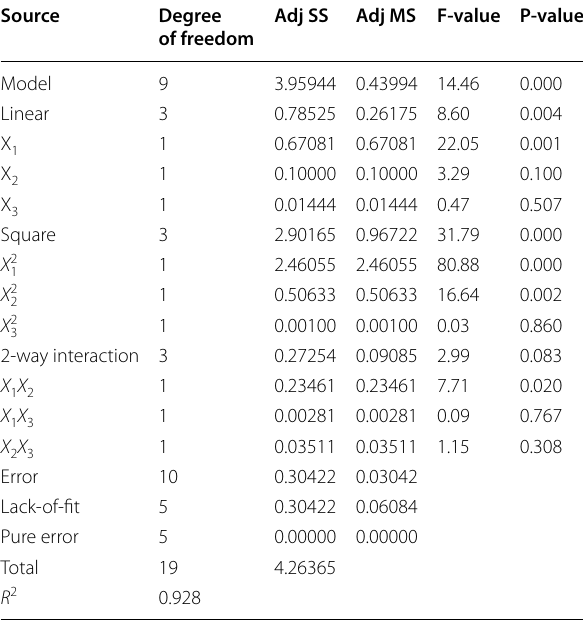
Table 3 ANOVA for response surface polynomial equation and corresponding F-values and p -values for zeaxanthin production by A.